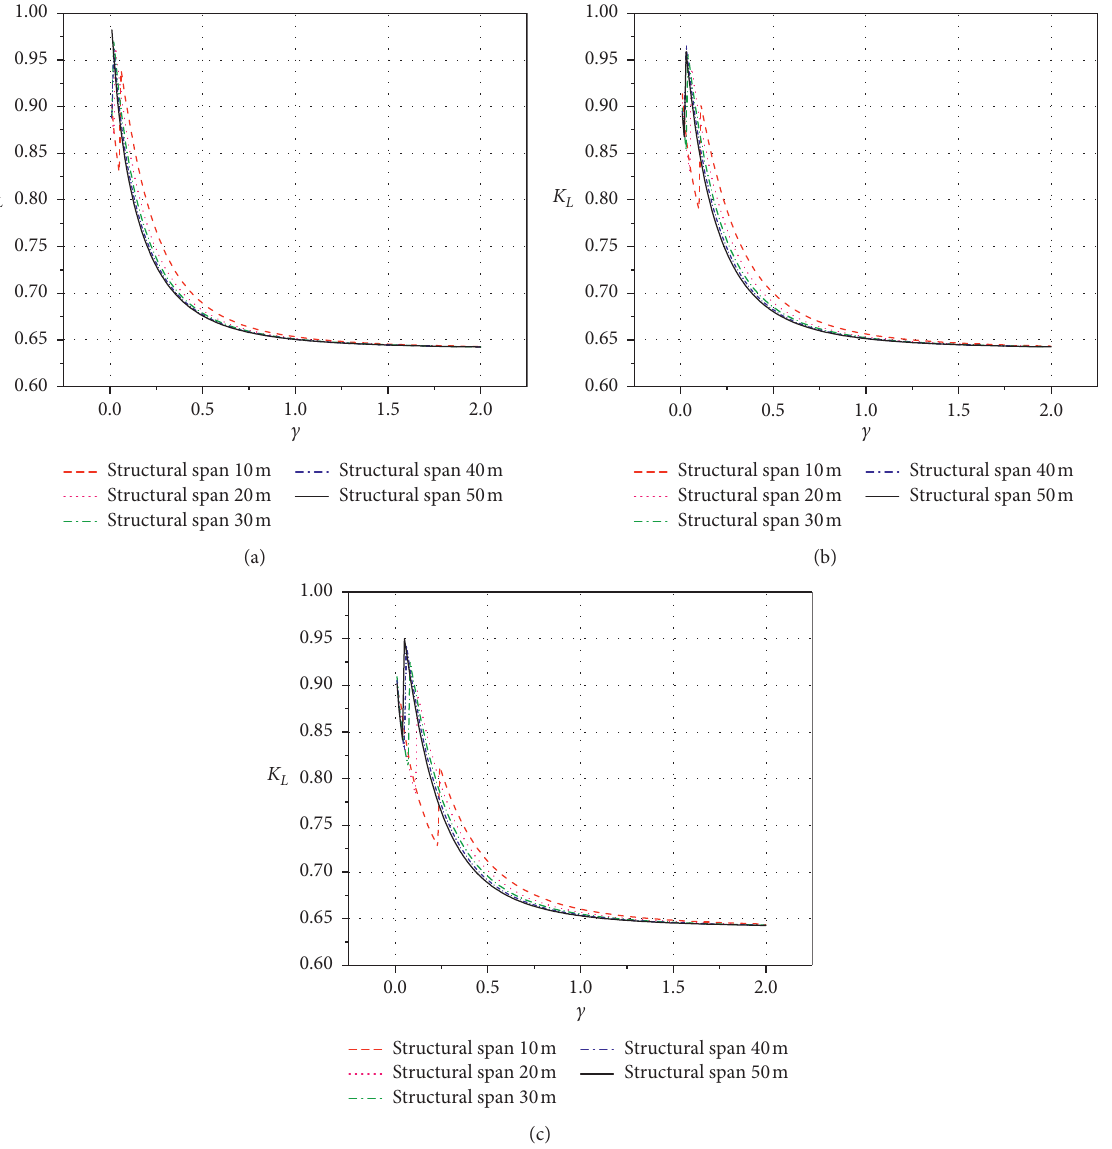
Figure 3: Equivalent load transformation factors of simply supported one-way members using Baker’s formula parameters: (a) W � 1kg. (b) W � 10kg. (c) W �